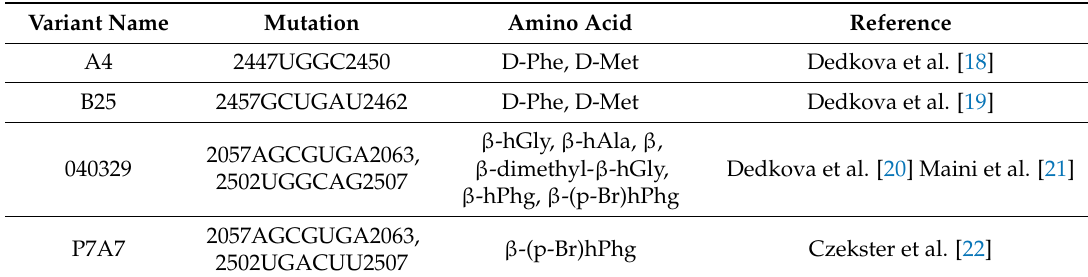
Figure 3. Engineering of ribosomal RNA for the incorporation of D - and β -amino acids. ( A ) Secondary structure of Escherichia coli 23S rRNA, domain V (excerpt). Positions of mutations introduced for D -amino acid incorporation are indicated by red circles, whereas those for β -amino acid incorporation are indicated by purple circles. ( B ) Structures of amino acids tested in translation using the engineered ribosome containing 23S rRNA mutations. Table 2. List of the 23S rRNA mutants for D - and β -amino acid incorporation. Mutations introduced into 23S rRNA and the amino acids tested for translation are shown.